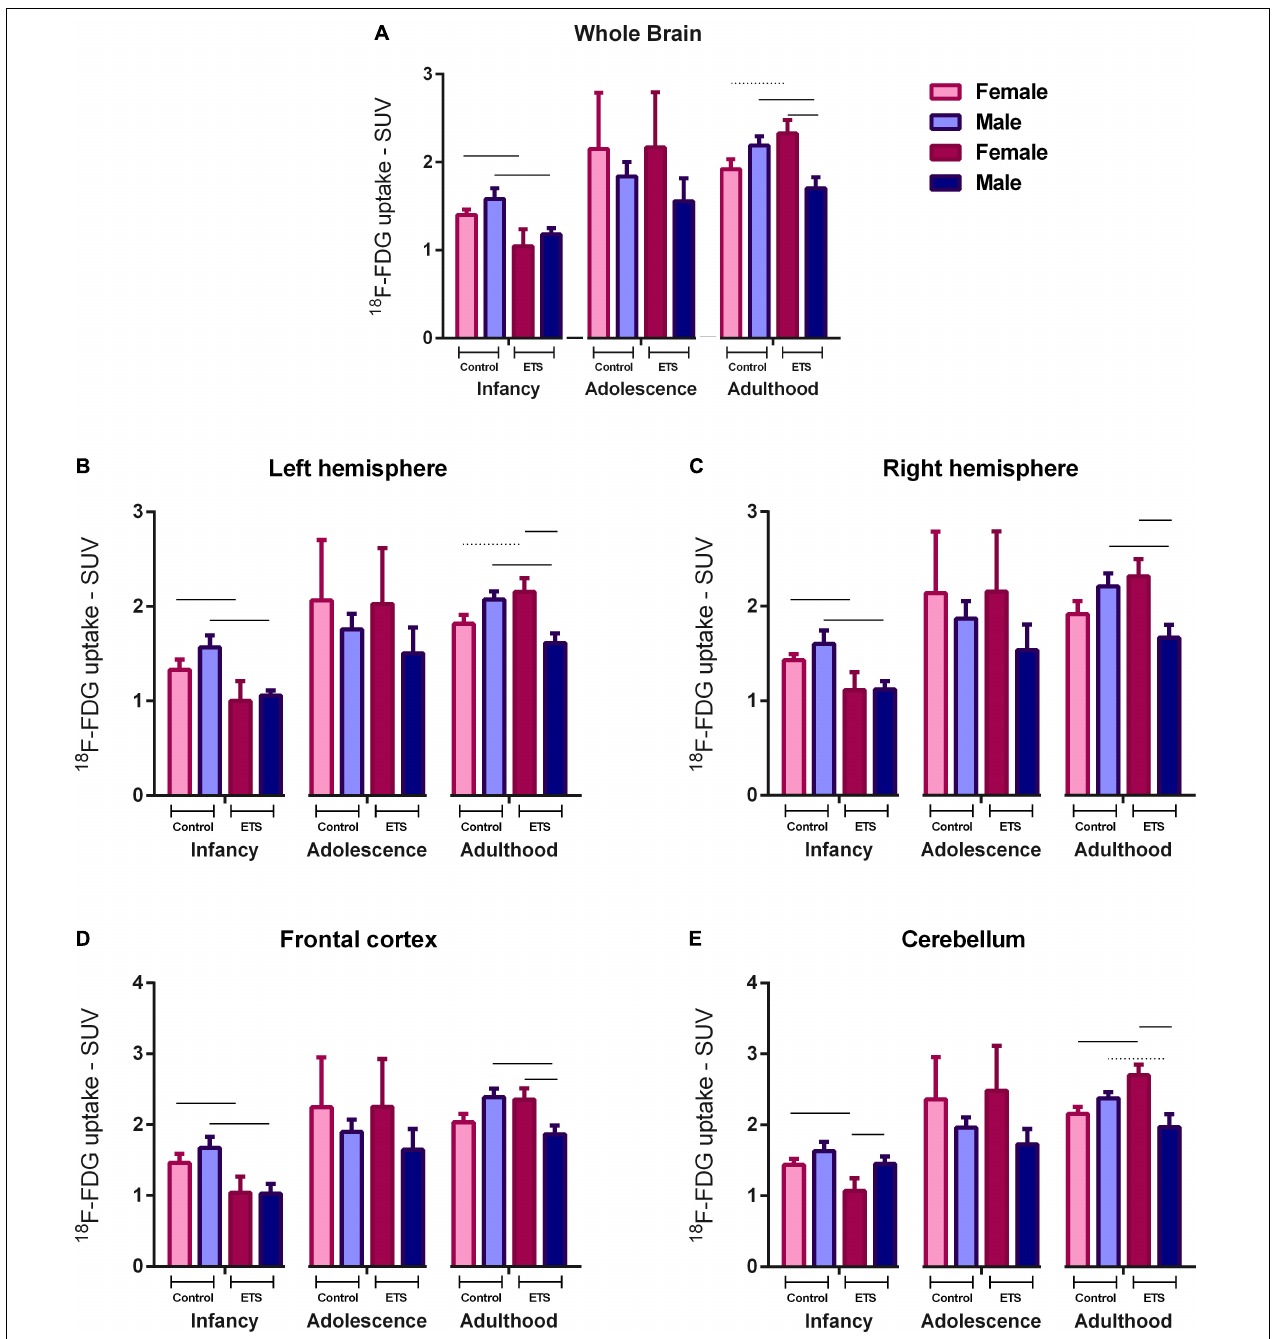
FIGURE 1 | 18 F-FDG uptake in the whole brain (A) , left hemisphere (B) , right hemisphere (C) , frontal cortex (D) , and cerebellum (E) for female and male infant ( n = 5 females ETS-exposed and n = 4 females control; n = 5 males ETS-exposed and n = 5 males control), adolescent ( n = 4 females ETS-exposed and n = 4 females control; n = 5 males ETS-exposed and n = 5 males control), and adult ( n = 5 females ETS-exposed and n = 4 females control; n = 5 males ETS-exposed and n = 5 males control) mice exposed to ETS during the early postnatal period. Three-way mixed ANOVA with repeated measures (groups × VOIs) and post hoc paired t -test (Bonferroni) with multiple comparison correction. Continuous bar: p < 0.05. Dashed bar: trend toward statistical significance.